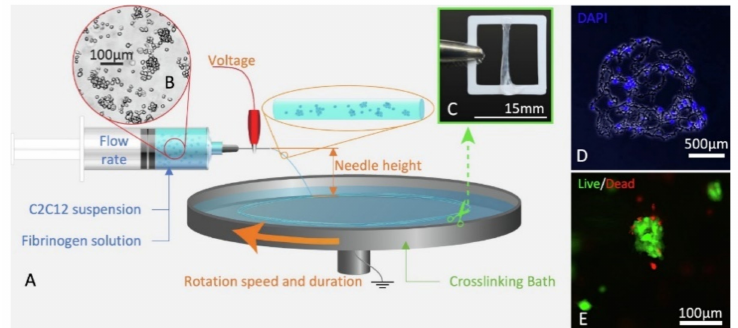
Figure 4. C2C12 can be electrospun into fibrin scaffolds. ( A ) Schematic of cell-laden wet- electrospinning setup identifying key parameters. ( B ) Bright field image of an aggregated cell suspension. ( C ) Cell-laden scaffold wrapped around ABS frame. ( D ) Cross-section of a cell-laden scaffold on Day 0 stained with DAPI (blue, nuclei). ( E ) High (20 × ) magnification of cell-laden mi- crofiber bundles showing live (green) cells and dead (red) cells. For interpretation of the references to color in this figure caption, the reader is referred to the web version of this paper. Adapted from [17] with permission from